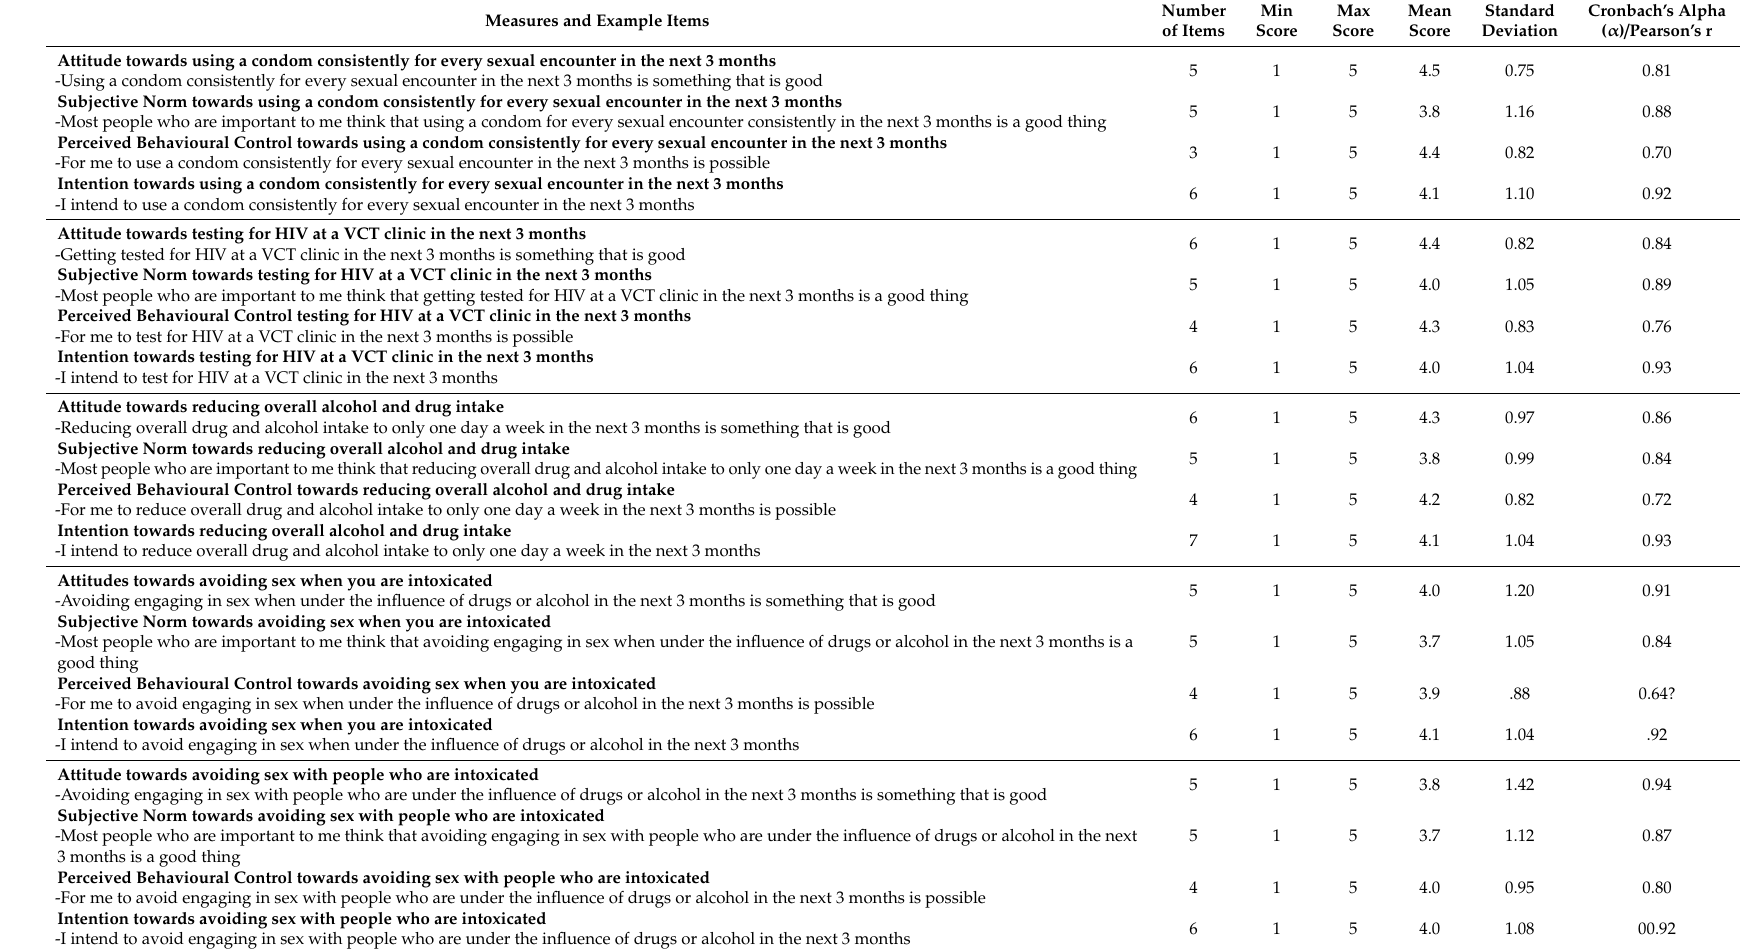
Table A1. Overview of the scale measures for pre-test